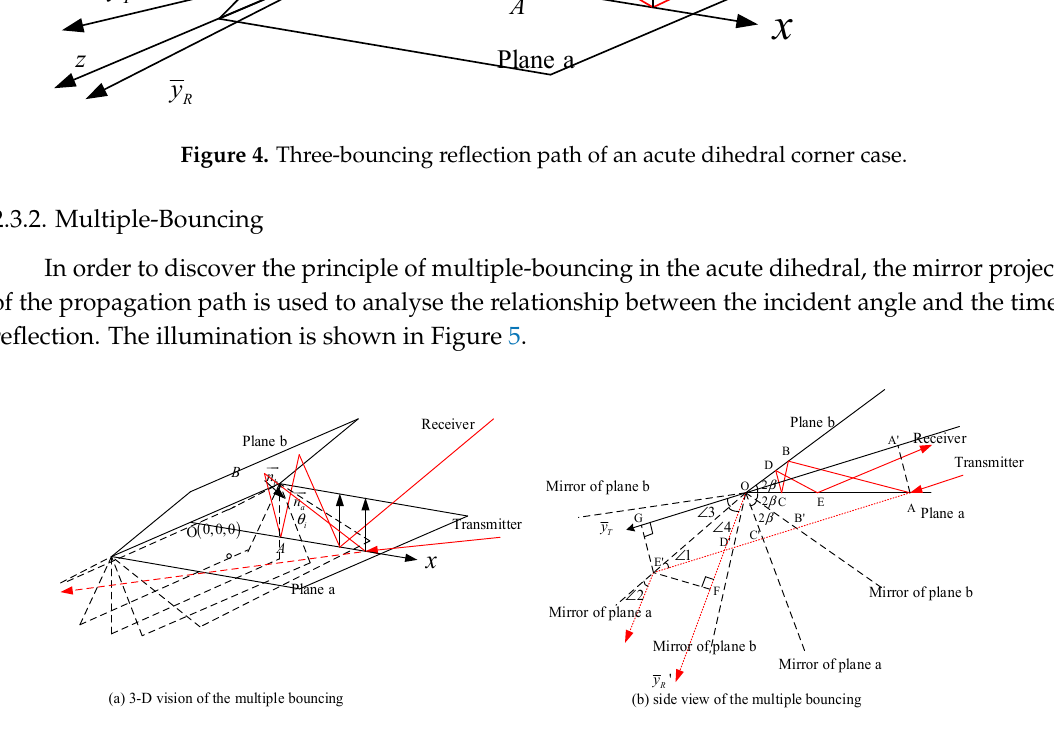
Figure 5. Equivalent propagation of multiple reflection ( a ) 3-D vision of the multiple bouncing; ( b ) side view of the multiple bouncing.